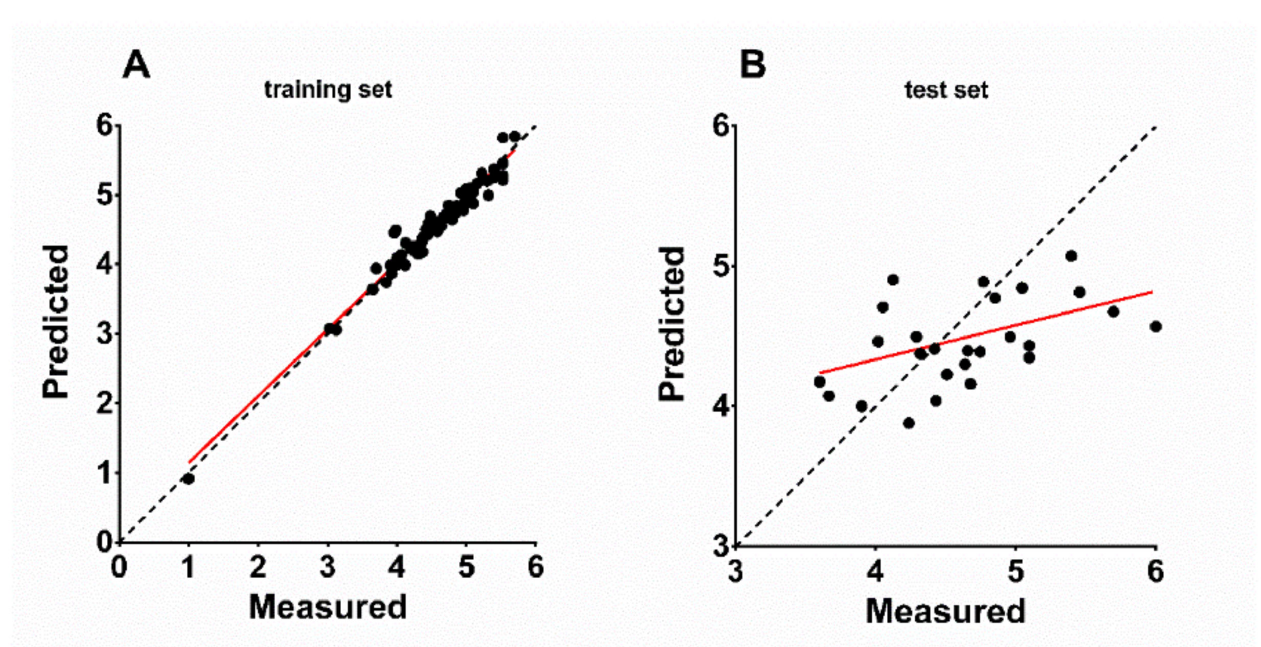
Figure 3. Predicted vs. measured binding affinities ( − log (IC 50 M)) of ( A ) training set and ( B ) test set NTCP inhibitor compounds based on the generated atom-based QSAR model. Red lines indicate linear regression of the scatterplots. ( A ) Training set (59 compounds, Table 1): R 2 = 0.9591, slope = 0.959. ( B ) Test set (26 compounds, Table 4): R 2 = 0.2163, slope = 0.2439. Bisector (dashed line) illustrates optimal